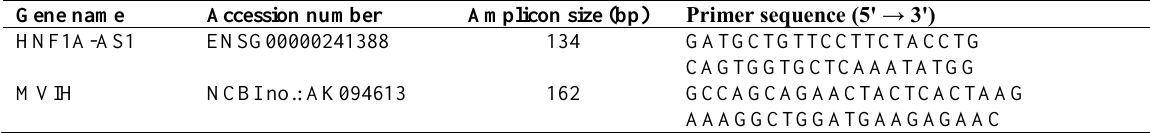
Table 1 . Sequences of